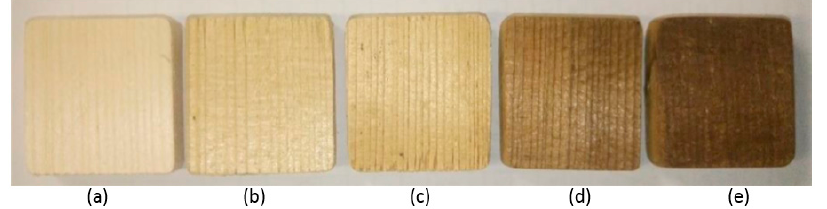
Figure 2. The control sample ( a ) and the thermally modified samples heated at 160 °C ( b ), 180 °C ( c ), 200 °C ( d ), 220 °C ( e ).